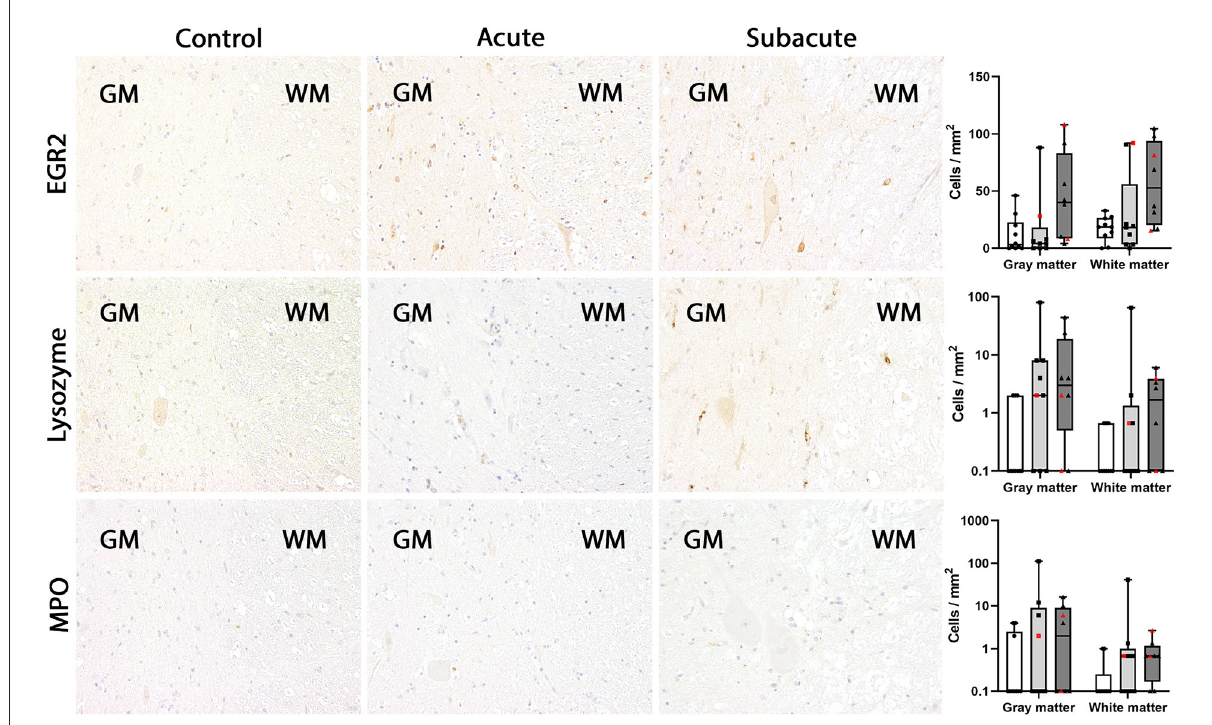
FIGURE4 EGR2, lysozyme and myeloperoxidase (MPO) expression in the canine spinal cord. In control dogs, EGR2-, lysozyme- and MPO-positive microglia/macrophages were rarely detected in gray and white matter. The numbers of immunopositive cells did not change significantly in dogs with acute and subacute spinal cord injury (SCI). In dogs with subacute SCI, higher numbers of EGR2-positive cells were found in gray and white matter of several dogs but significant difference between the groups was lacking. MPO-positive cells are not illustrated in this figure